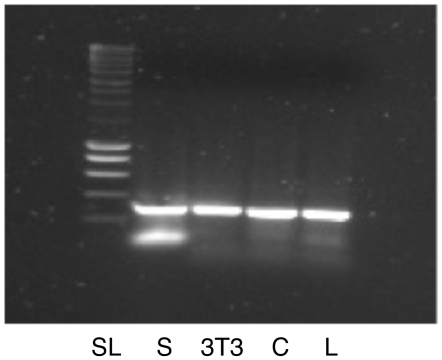
Amplification of 25-kDa ThTPase mRNA in different cell lines by RT-PCR.(SL, standard ladder; S, SN-K-BE; C, C2C12; L, LN-18).